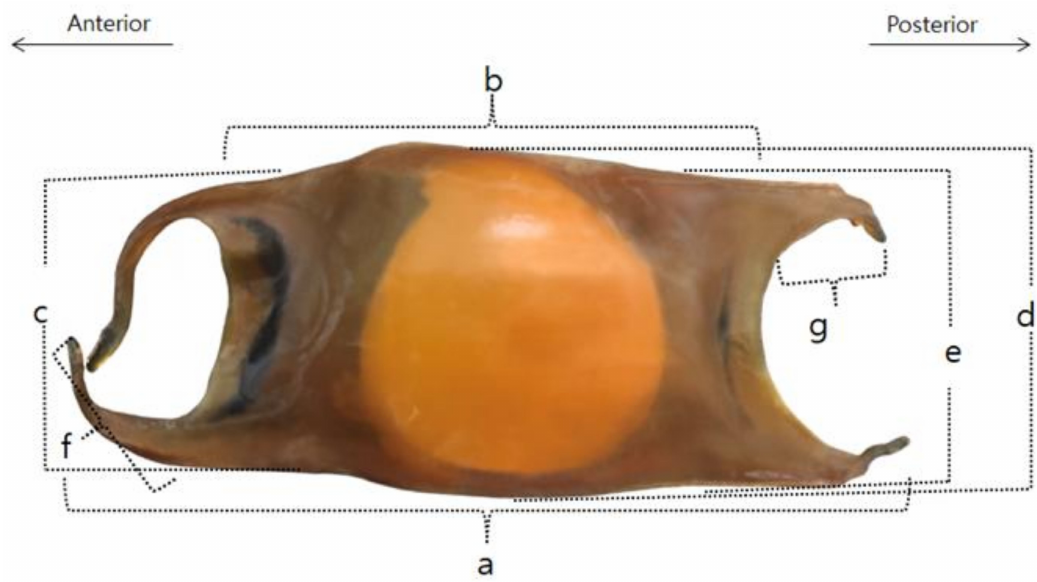
Figure 8. Diagrammatic representation of ocellate spot skate Okamejei kenojei egg capsule (dorsal view) with measurements indicated in parenthesis. a: Total length (85.3 mm), b: Central chamber length (45.1 mm), c: Width of anterior horn (25.0 mm), d: Width of capsule (30.1 mm), e: Width